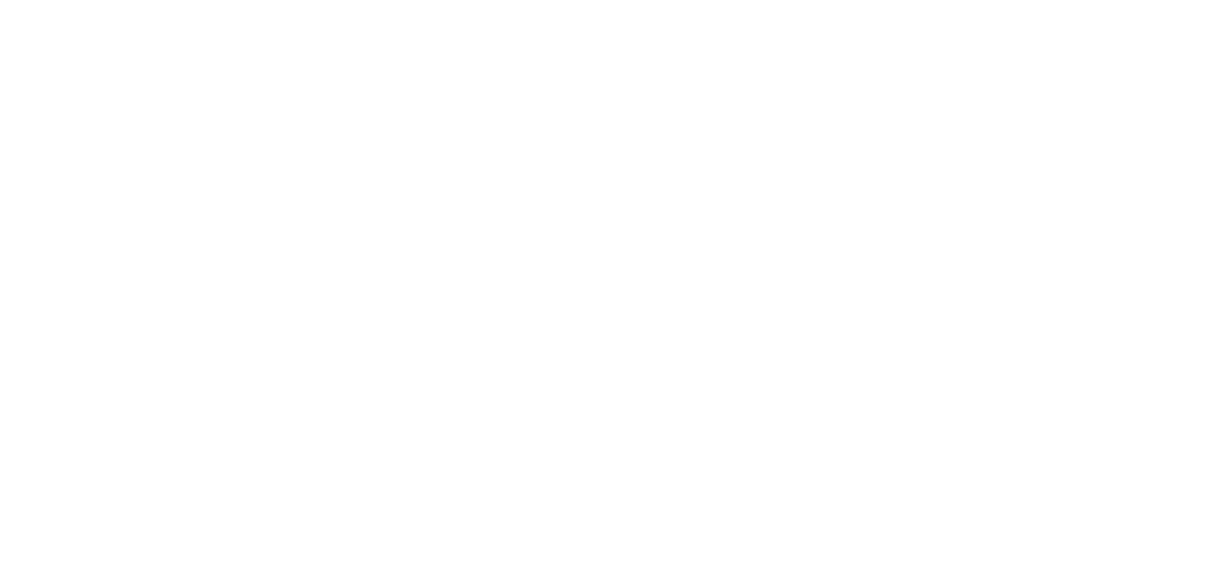
Frontiers in Psychology | Cognitive